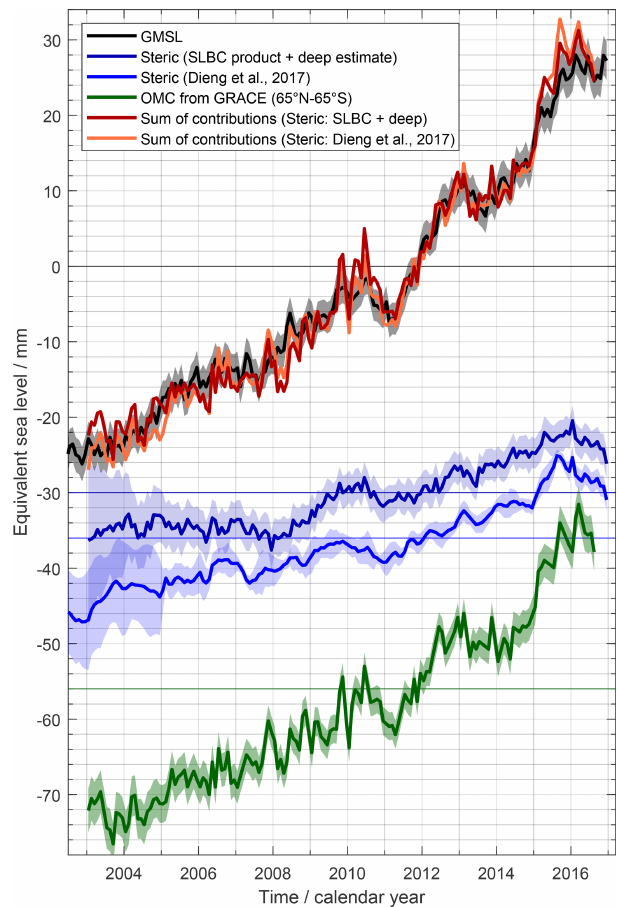
Figure 13. Time series of SLB elements involving the GRACE- based assessment of ocean-mass change. See legend for attribu- tion of graphs. The GRACE-based time series were interpolated to monthly sampling. Seasonal variations are subtracted. Each graph shows anomalies with respect to a mean value over 2006–2015. Graphs are shifted arbitrarily along the ordinate axis. Standard un- certainties are shown by transparent bands (except for the sum-of- contribution